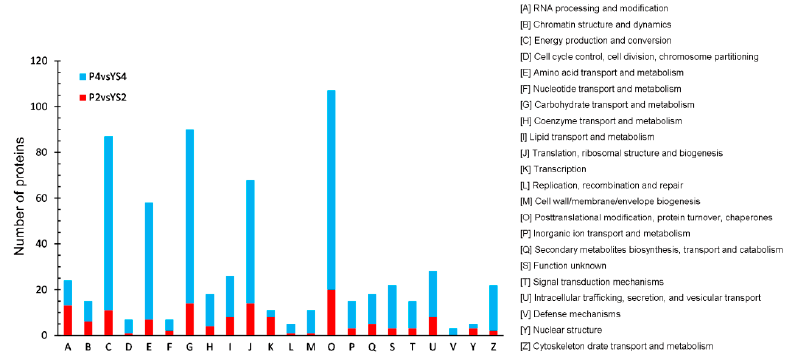
Figure 8. KOG functional classification of DEPs in stage 2 and 4. Capital letters on the x ‐ axis rep